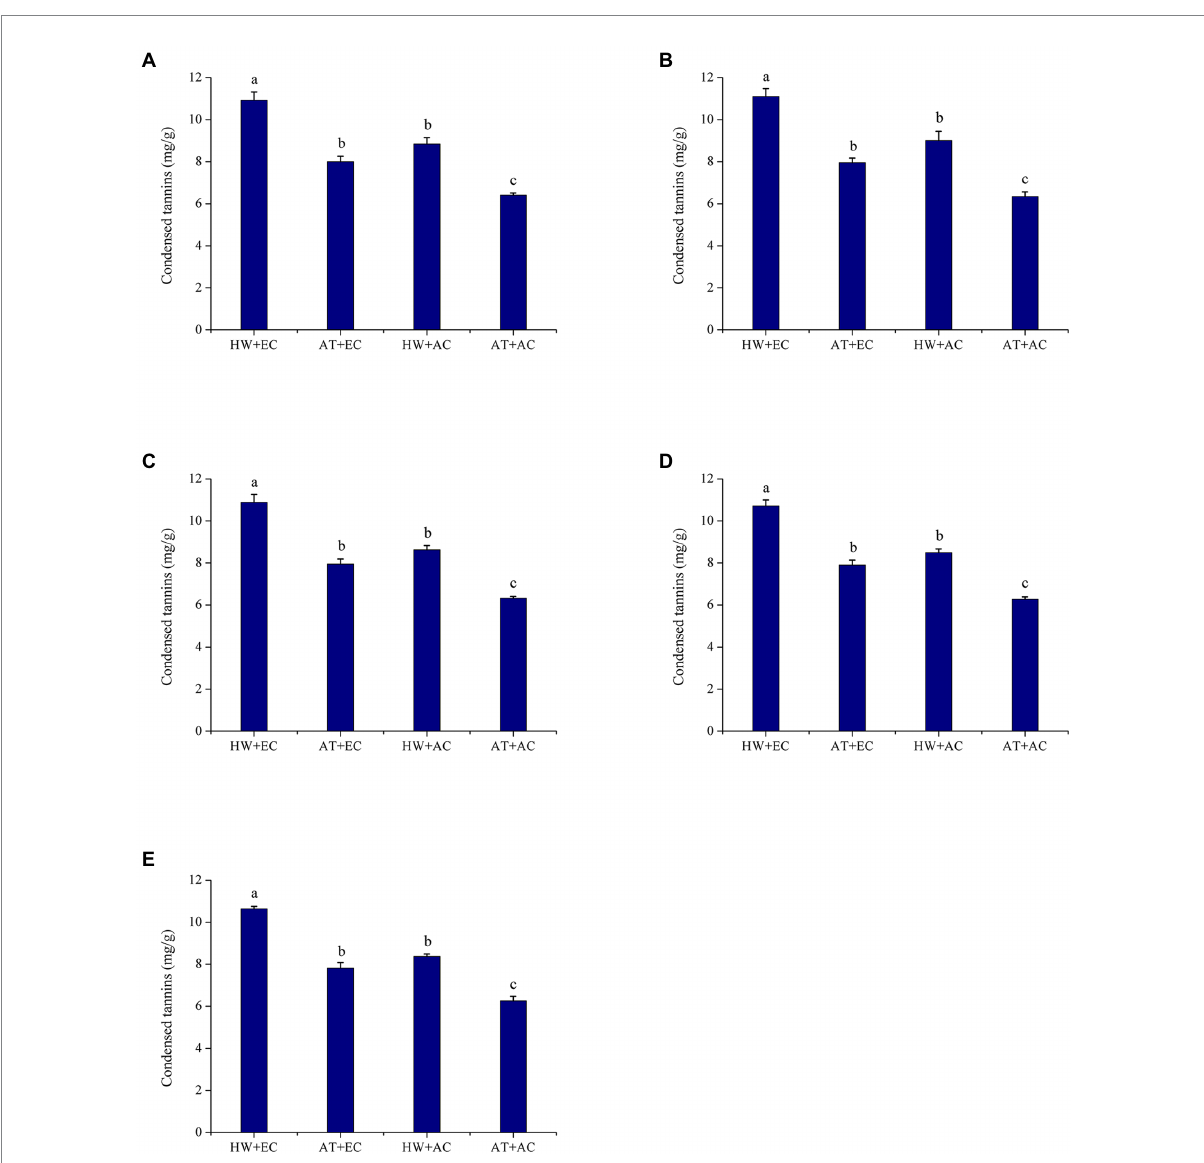
FIGURE 2 Condensed tannins concentration (±SE) of Ambrosia artemisiifolia under different stress conditions ( n = 5). Data represented by columns bearing the same letters were not significantly different (LSD, p = 0.05). (A–E) Represent the first, second, third, fourth, and fifth measurements, respectively. AT denotes the ambient temperature condition; HW denotes the heat wave condition. EC and AC represent elevated atmosphere CO 2 concentration and ambient atmosphere CO 2 concentration,